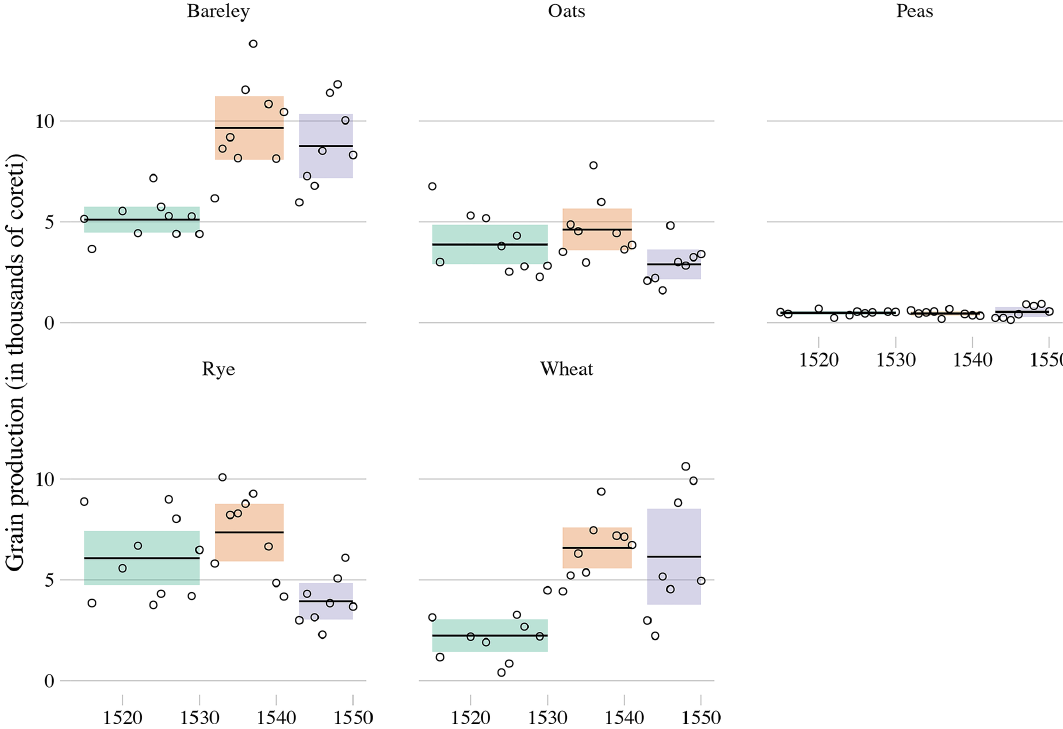
Figure 5. Volume of grain harvests in Malbork Royal Economy (calculated in coreti; 1 coretus = 55kg). Sources: Szpak